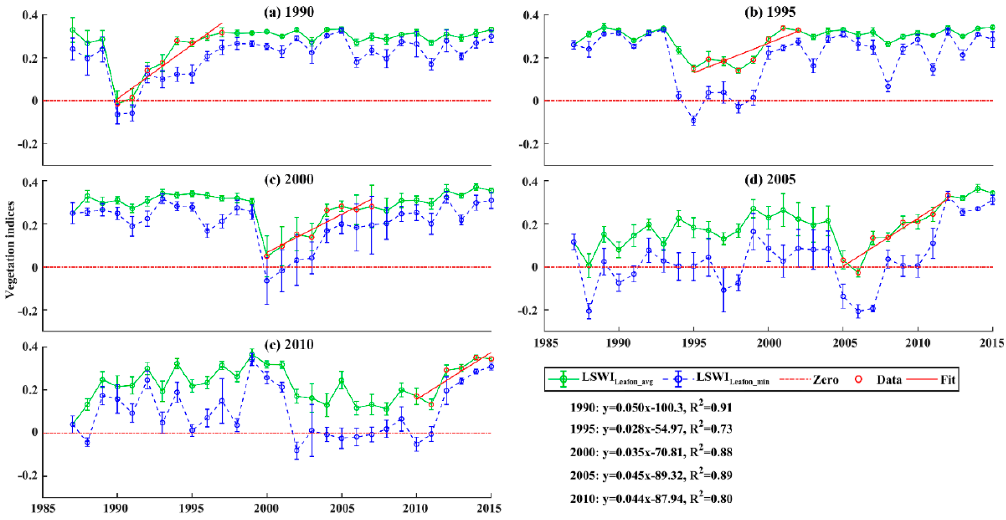
Figure 5. Temporal profile analysis of LSWI Leafon_avg and LSWI Leafon_min for five rubber plantations established in ( a ) 1990; ( b ) 1995; ( c ) 2000; ( d ) 2005; and ( e ) 2010, respectively. Linear fitting of LSWI Leafon_avg against year in non-production period in each rubber plantation are in red. Error bars indicate the standard deviation of LSWI Leafon_avg and LSWI Leafon_min . Rubber plantations of ( d , e ) were converted from cropland, while ( a – c ) were converted from evergreen forests or old rubber plantations.